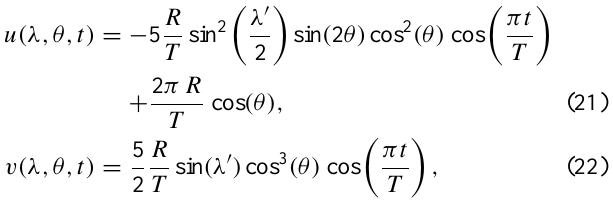
in Nair and Lauritzen (2010) for the computation of parcel